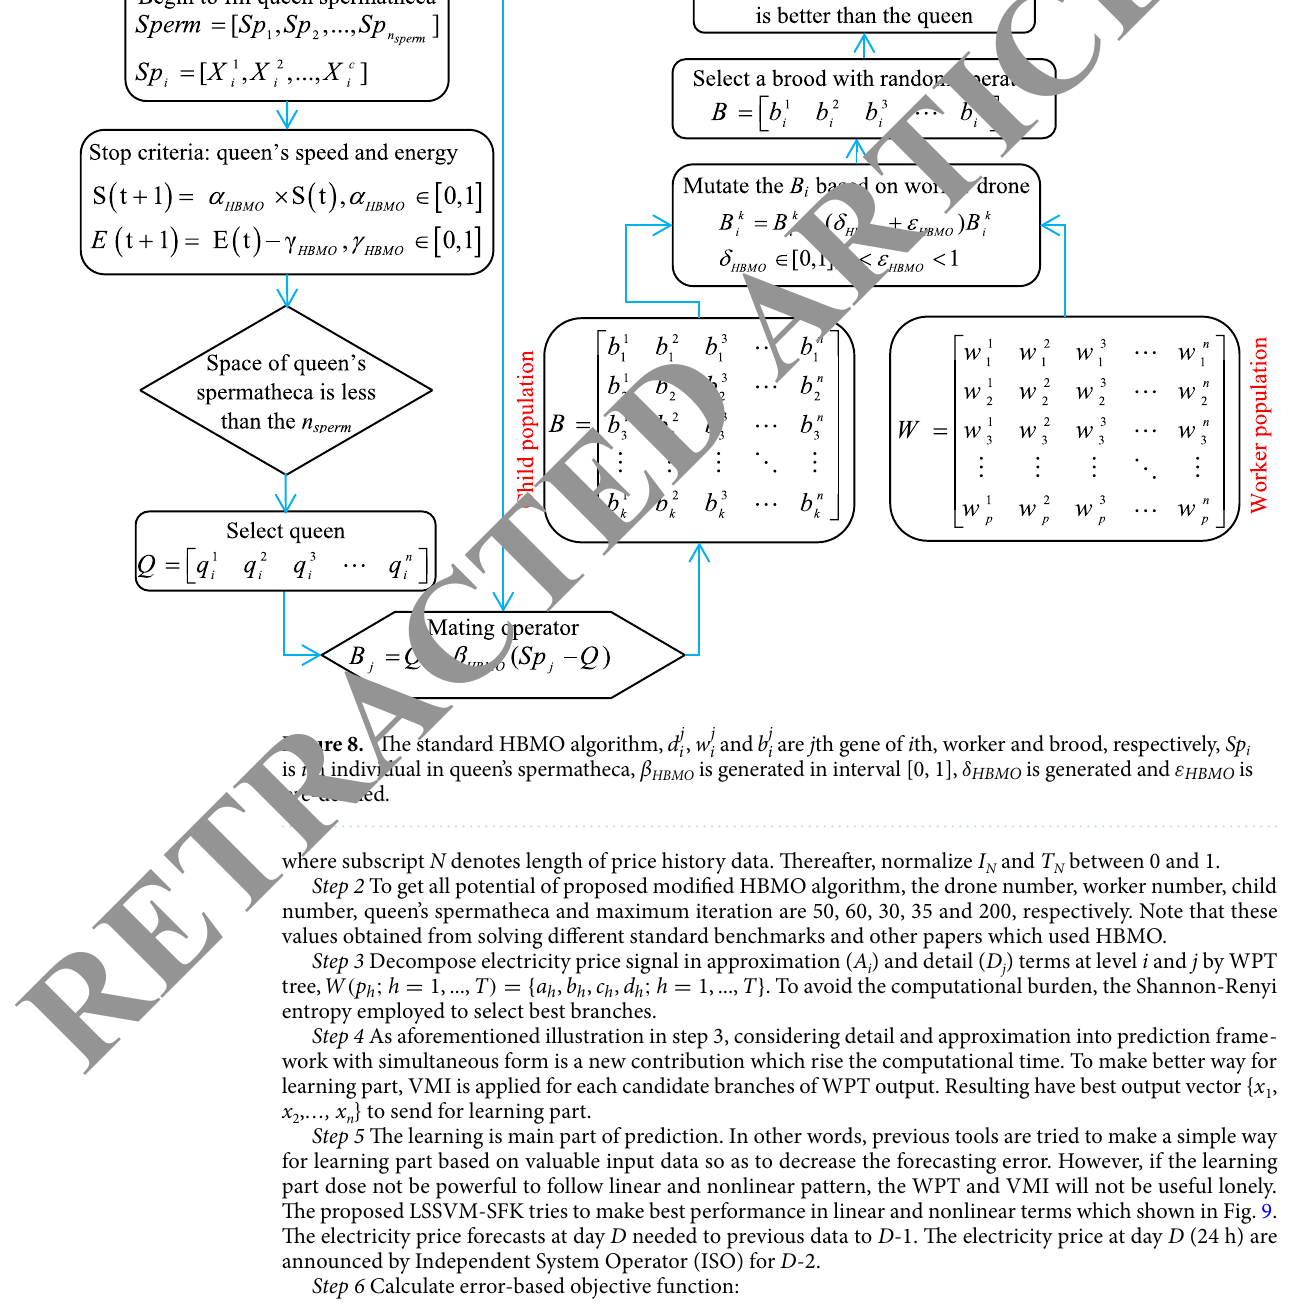
j , w j b j i i and i are j th gene of i th, worker and brood, respectively, Sp i